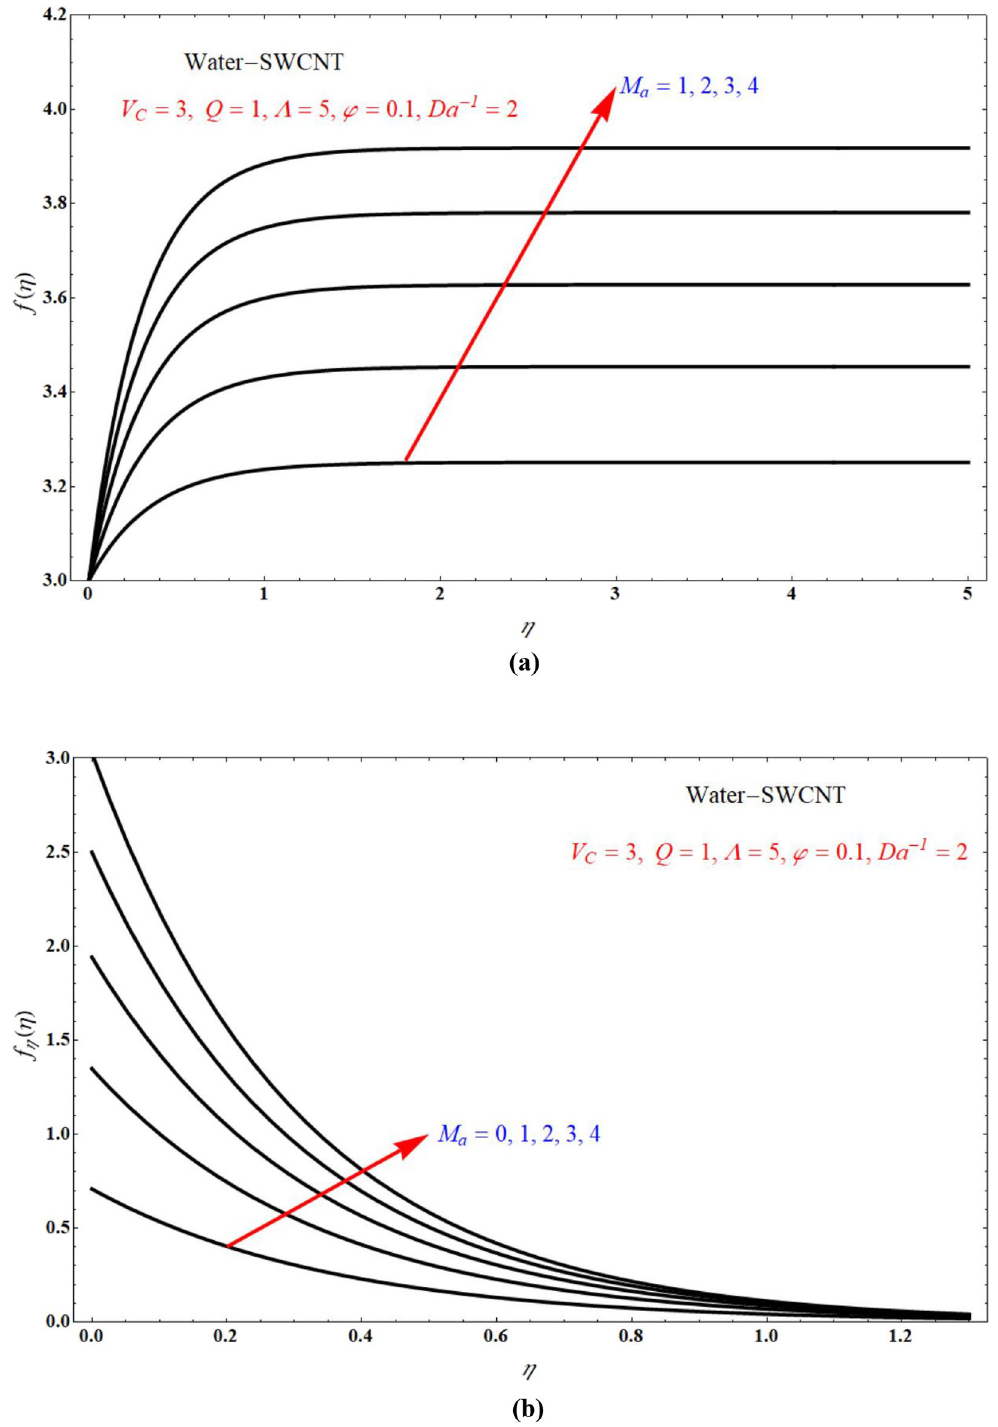
Figure 8. Plots of ( a ) f (η) verses η and ( b ) f η (η) verses η for different choices of M a at suction